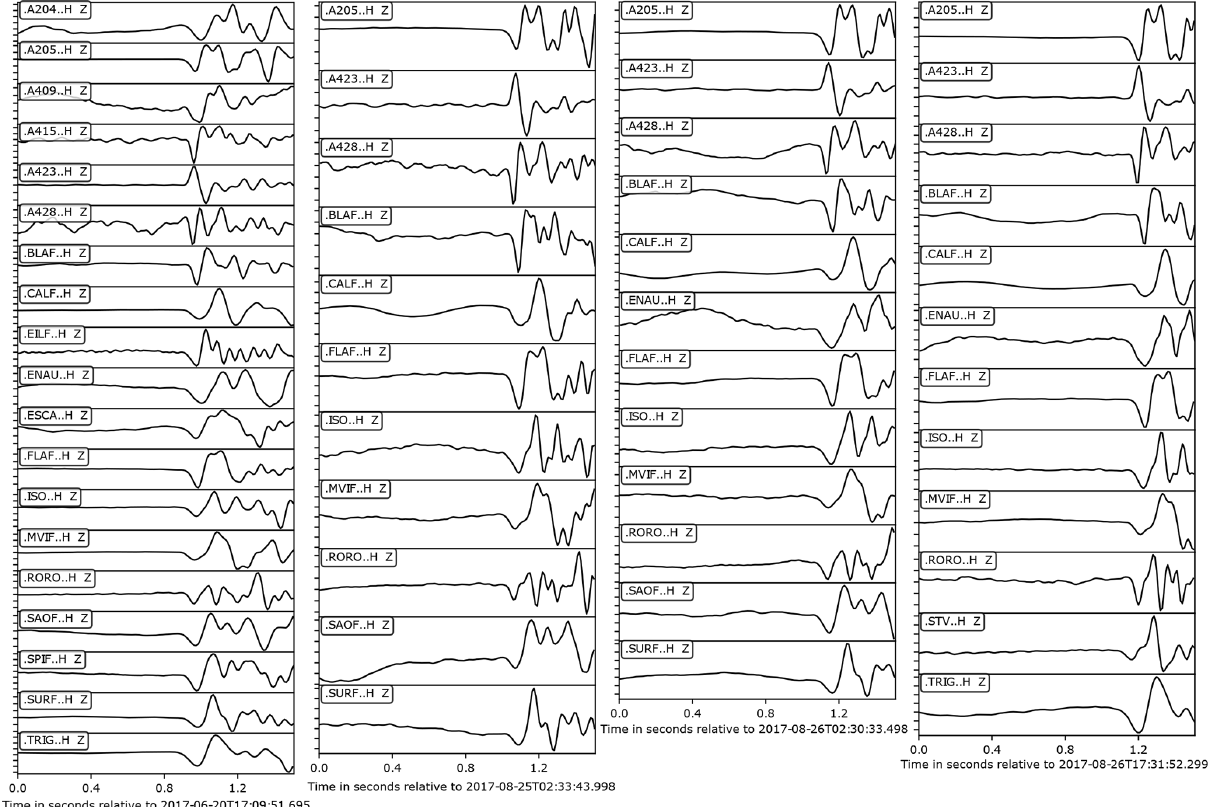
Figure A3. First motion polarities for events 2, 6, 8 and 9 from left to right.